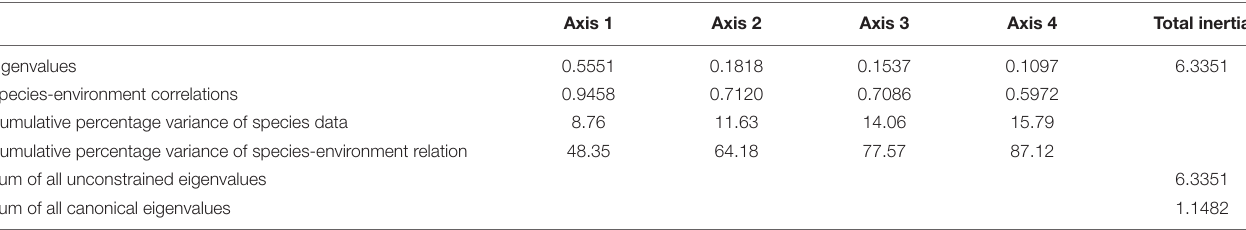
TABLE 4 | Canonical correlation analysis relating ichthyoplankton assemblages to abiotic and biotic factors in Sansha Bay of Fujian Province,